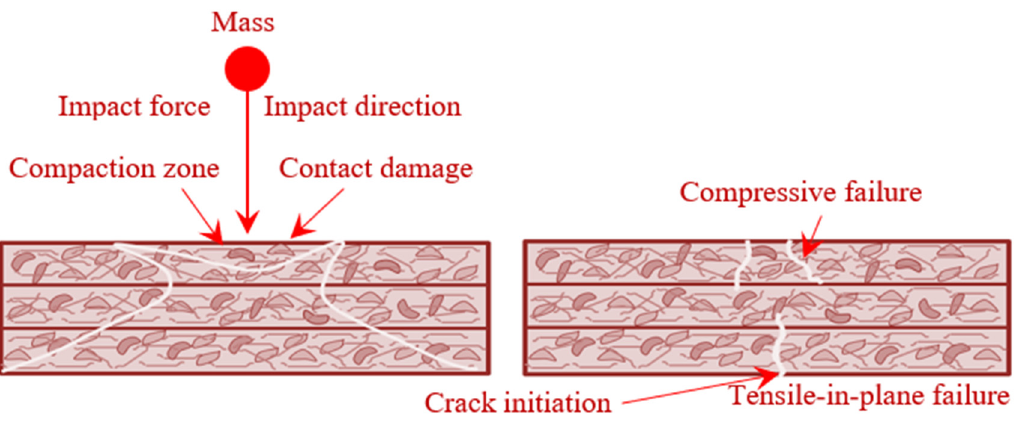
Figure 10. Failure mechanism.